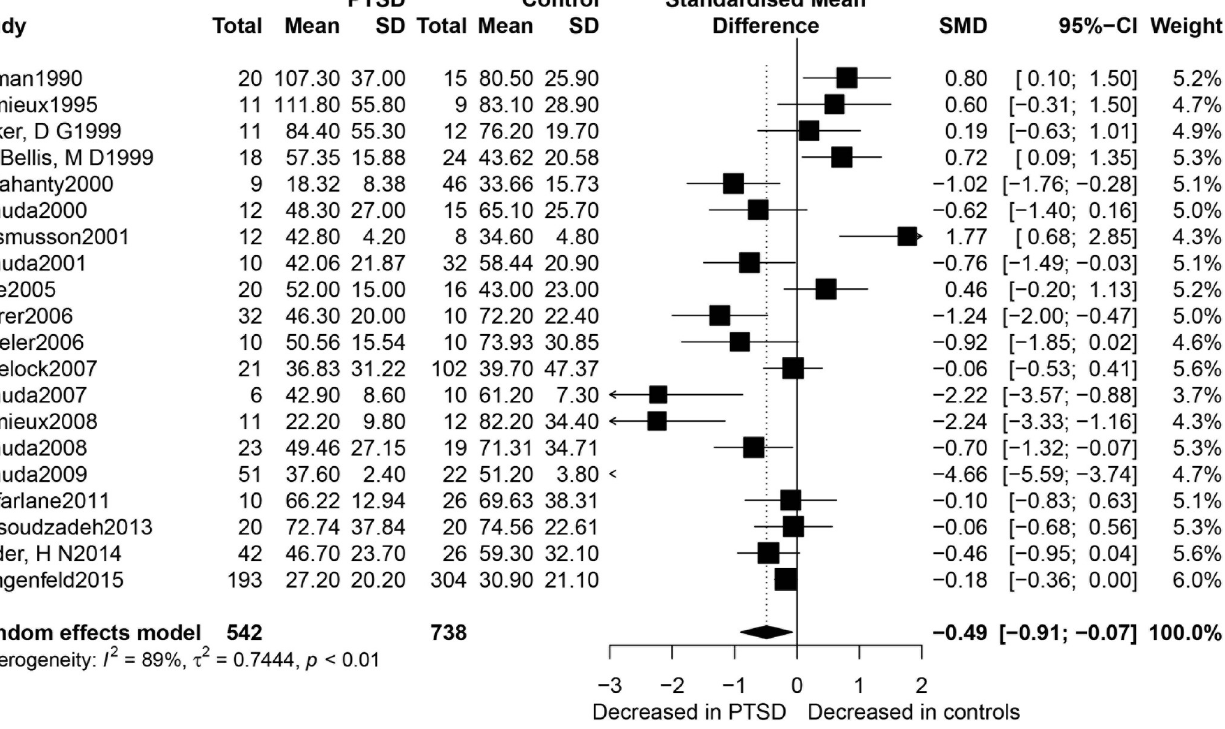
Fig 2. Forest plot of 24-h urinary cortisol between PTSD participants and controls. Study effect sizes of urinary cortisol concentrations differences between PTSD and controls. Each data marker represents a study, and the size of the data marker is proportional to the total number of individuals in that study. The summary effect size for each urinary cortisol concentration is denoted by a diamond. PTSD, post traumatic stress disorder; SMD, standardised mean difference.